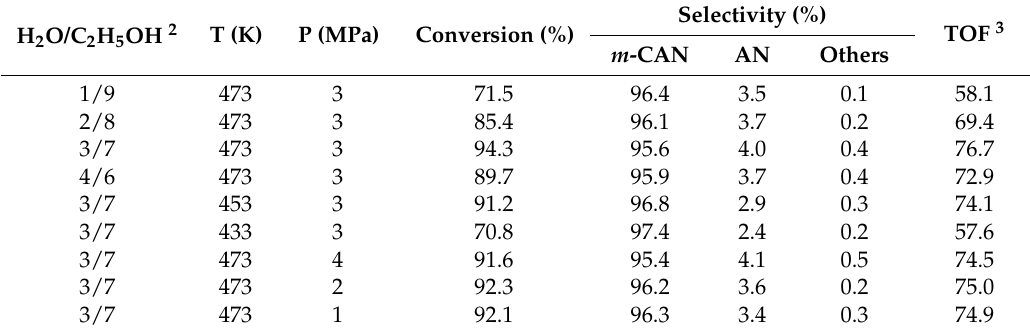
Table 4. In-situ hydrogenation of m -CNB over Pt–Fe(1.0)–in/CNTs.